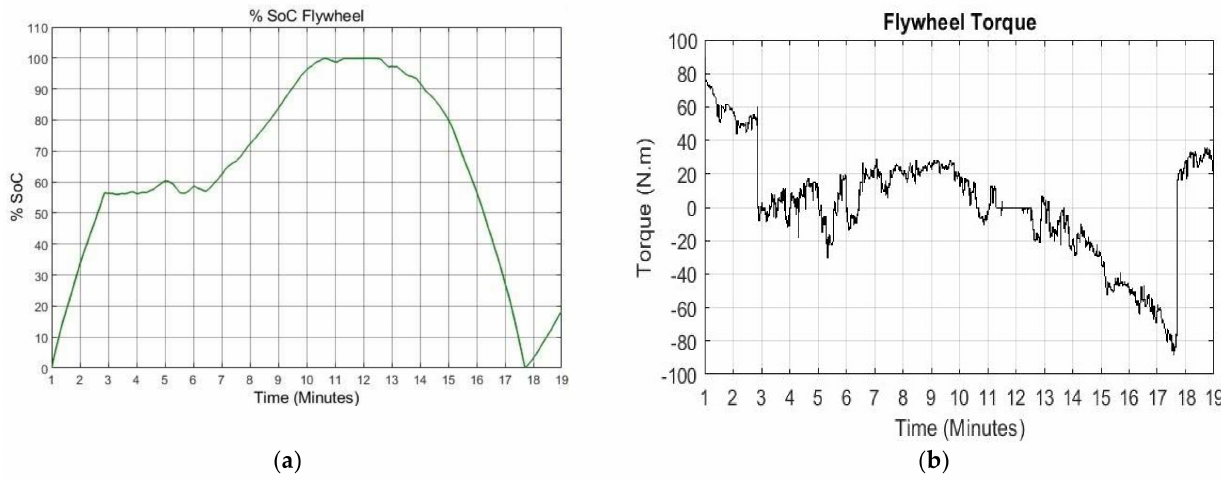
Figure 23. ( a ) %SoC of flywheel; ( b ) Flywheel